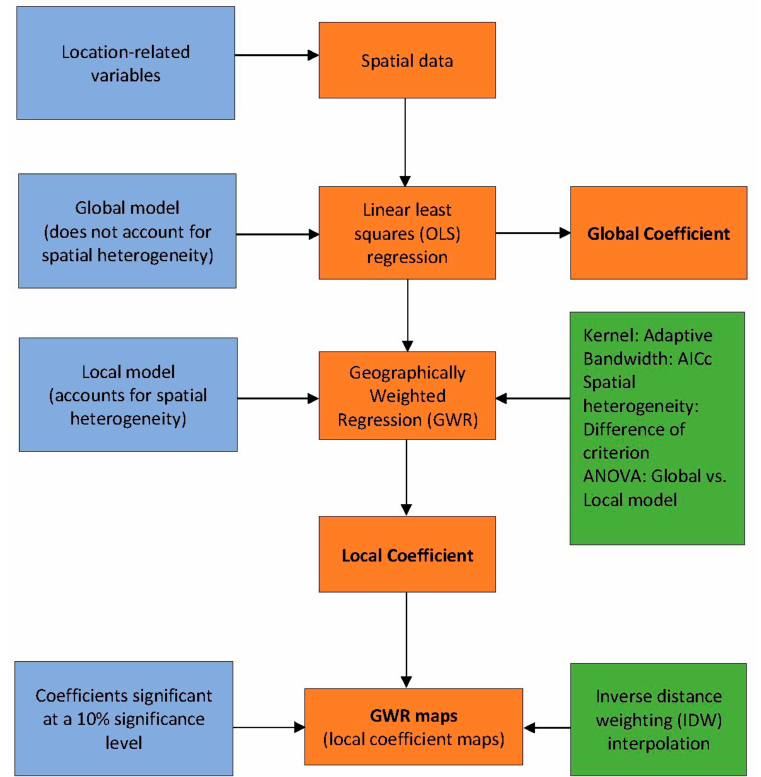
Figure 2. Analysis steps in extending the ordinary least squares (OLS) regression to the geographic weighted regression (GWR)